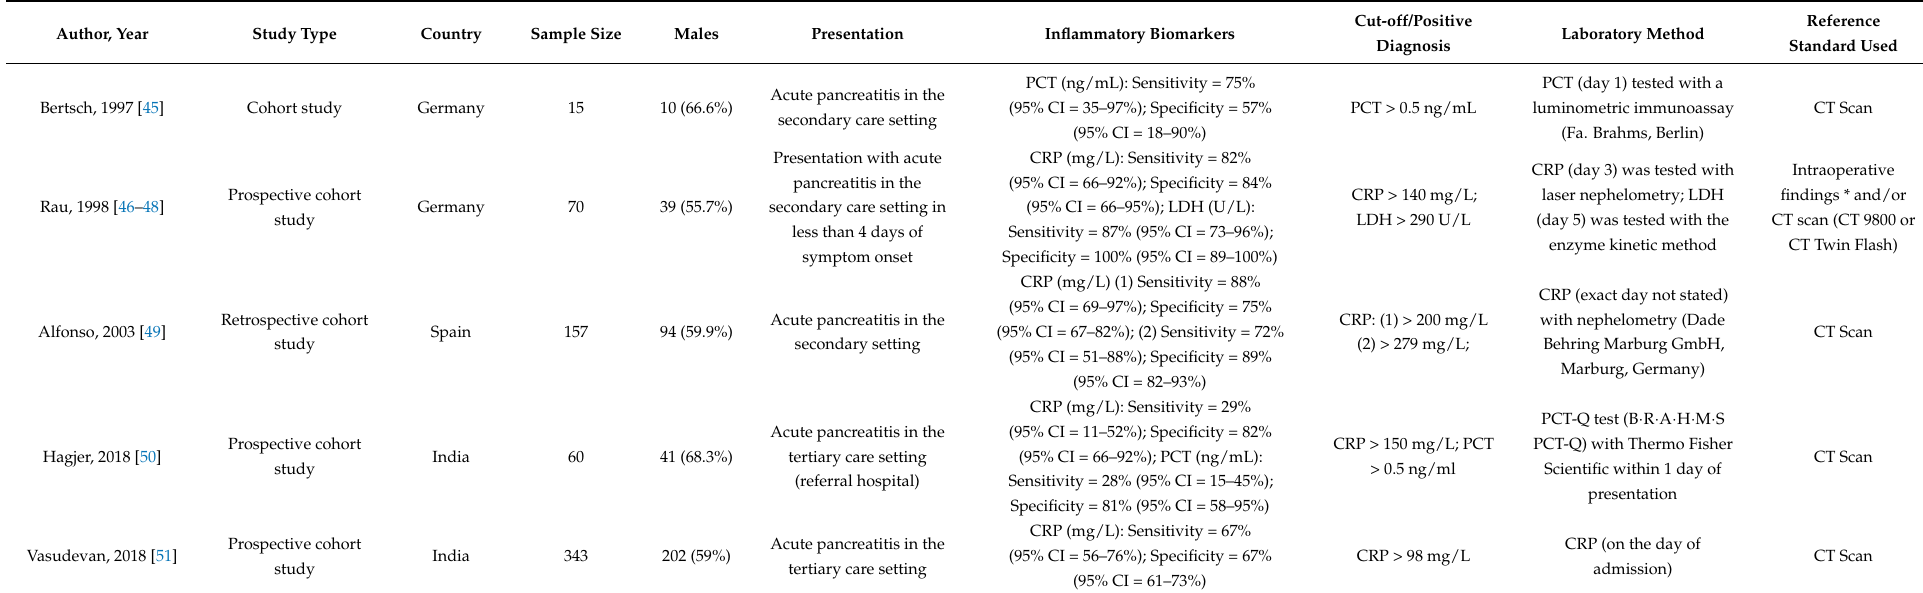
Table 2. Characteristics of included